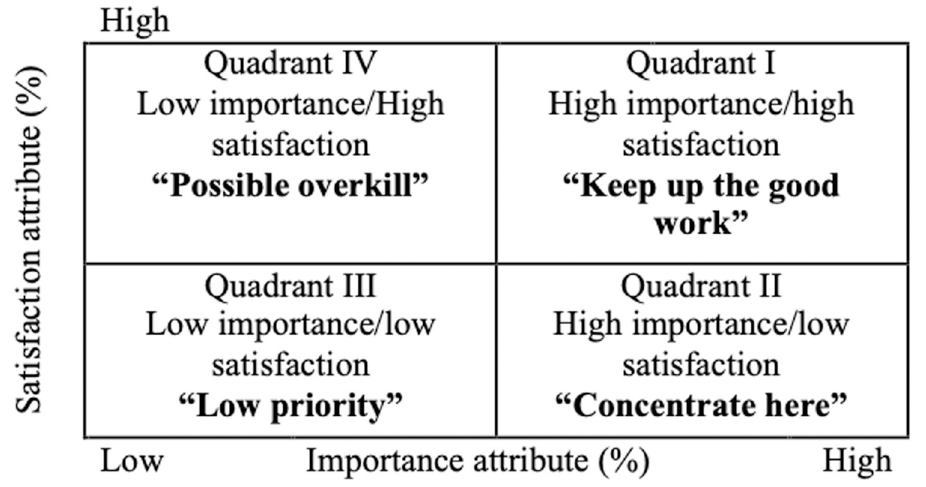
Fig 1. Importance-performance analysis